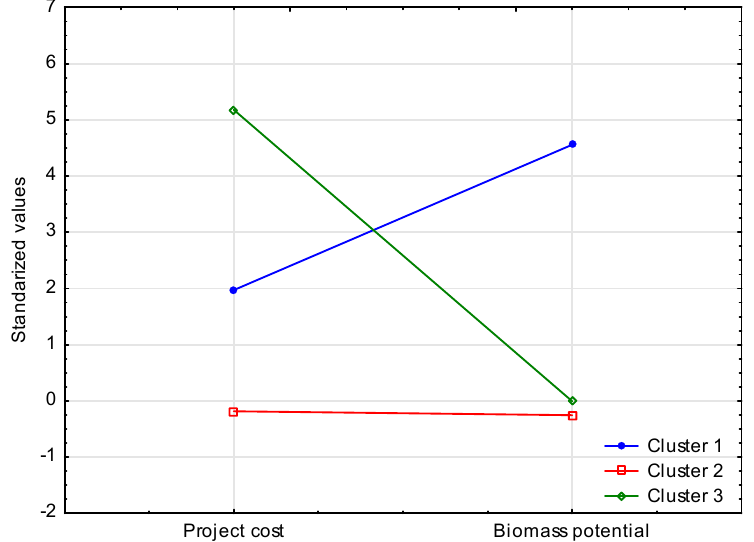
Figure 7. Standardized average project costs and biomass potential.